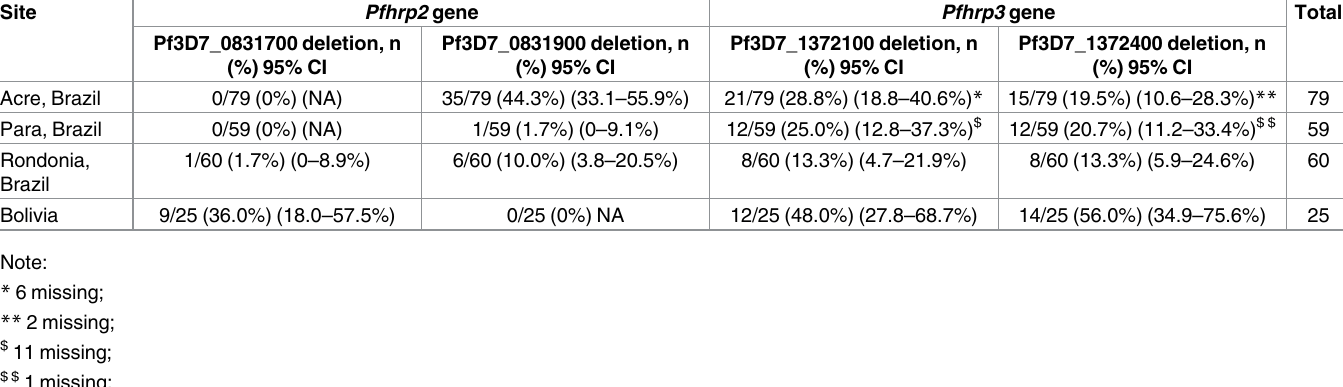
Table 2. Deletions of pfhrp2 and pfhrp3 flanking genes in samples from Brazil (198 samples) and Bolivia (25